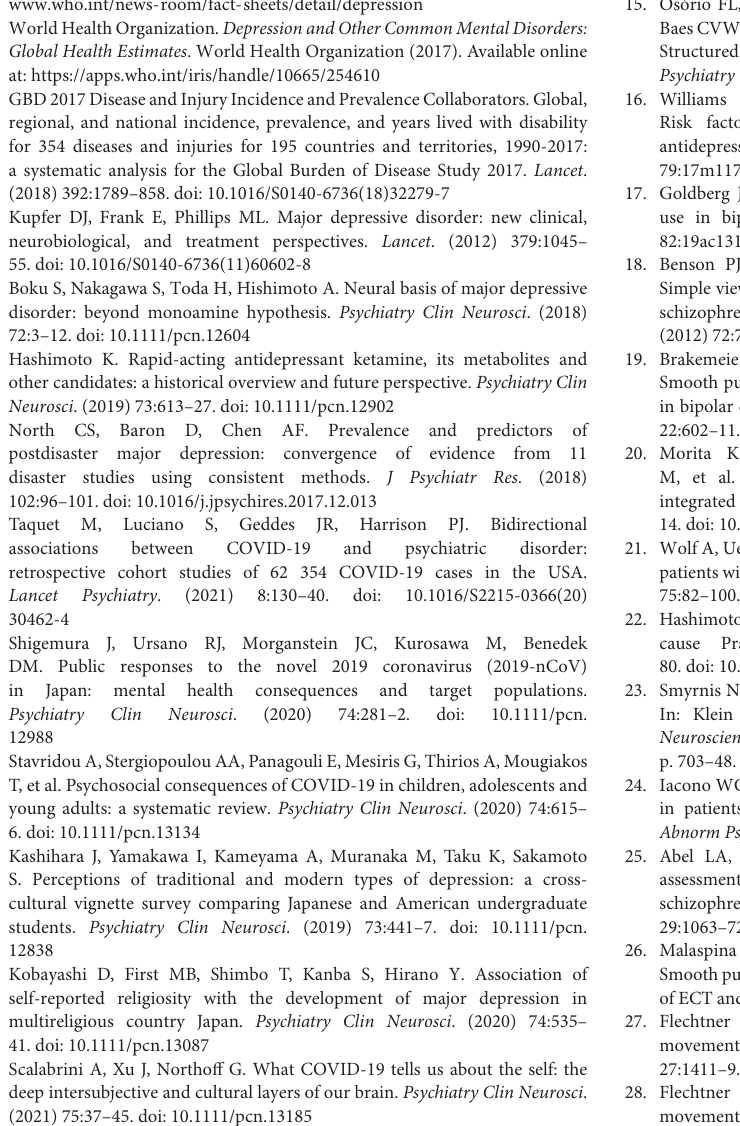
Supplementary Figure 1 | Receiver-operator curve (ROC) to predict patients with major depressive disorder. Area under the ROC = 0.77 (standard